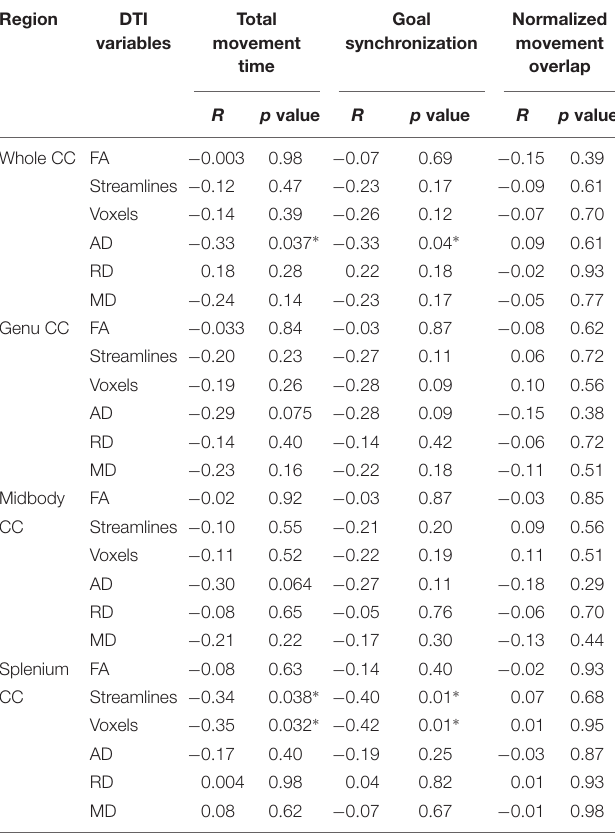
TABLE 2 | Correlation analyses between temporal coordination measures and DTI